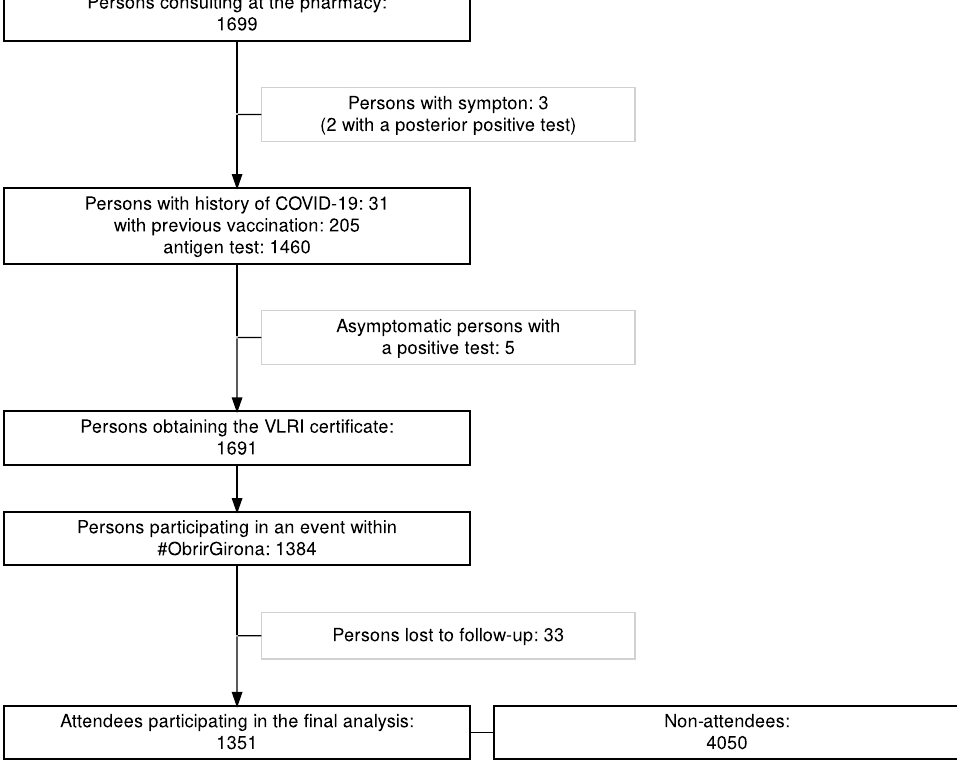
Figure 1. Flowchart of participation in the study.